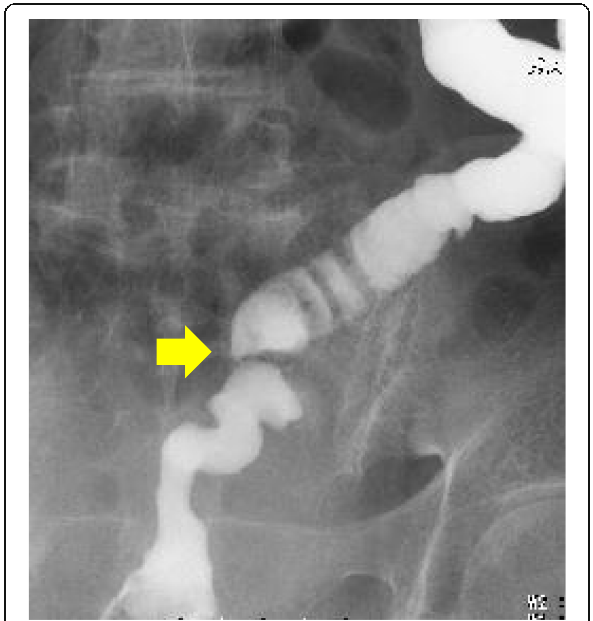
Fig. 2 Severe stenosis of anastomosis of the sigmoid colon before treatment (arrows)